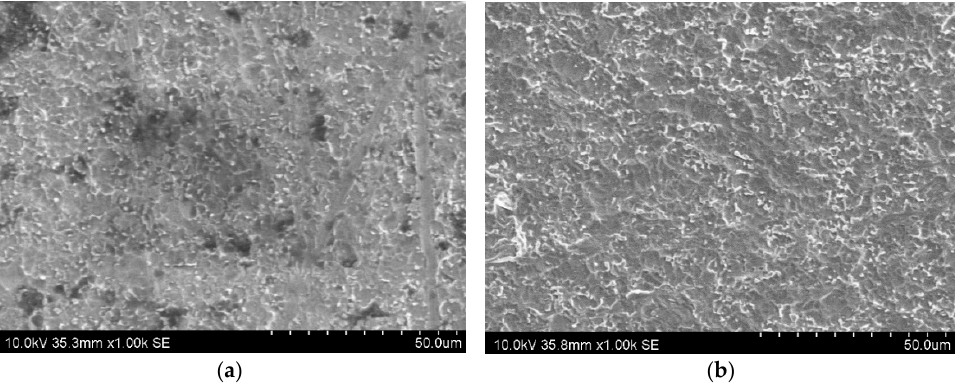
Figure 3. Scanning electron microscopic images showing the sample surface condition (Ra of ~450 nm) (laser cleaning performed with a frequency-tripled Nd:YAG laser operating at a wavelength of 355 nm, beam size of 1 mm 2 , fluence of 0.55 J/cm 2 , number of pulse/position of 30 and frequency of 10 Hz), ( a ) Before cleaning, ( b ) After cleaning.